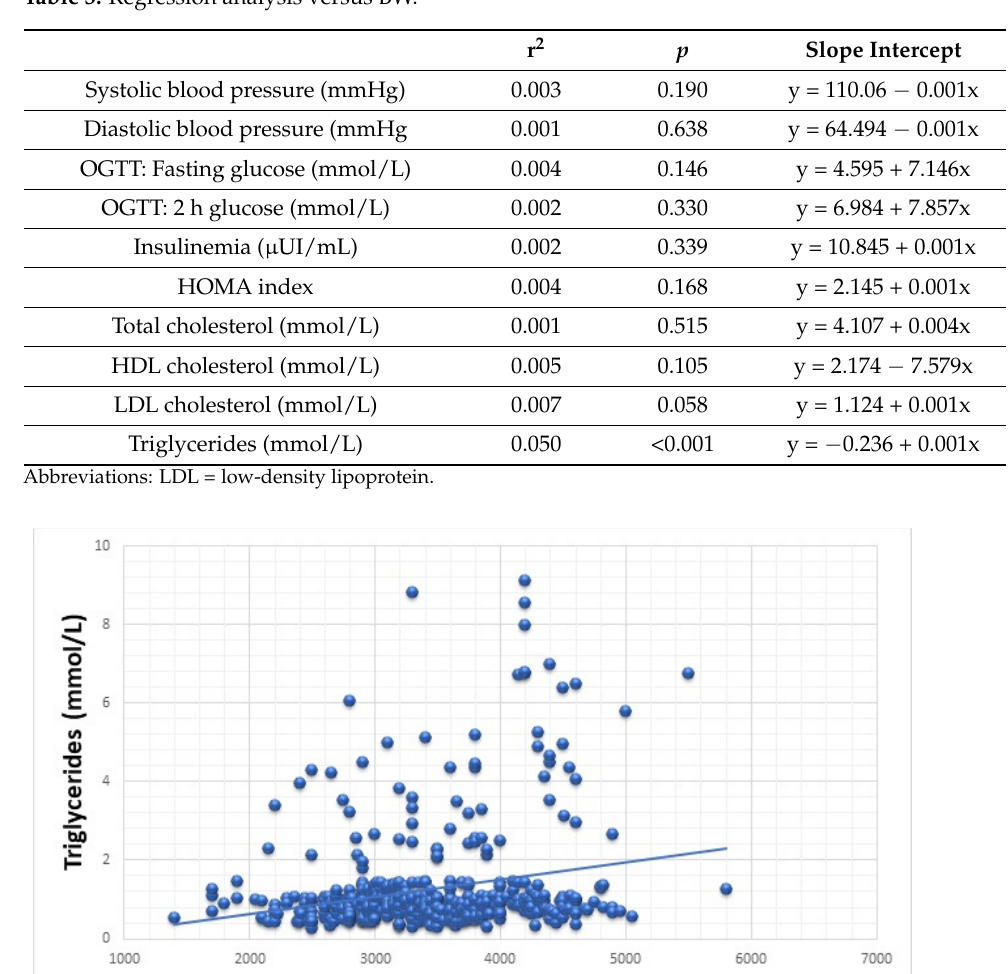
Table 3. Regression analysis versus BW.